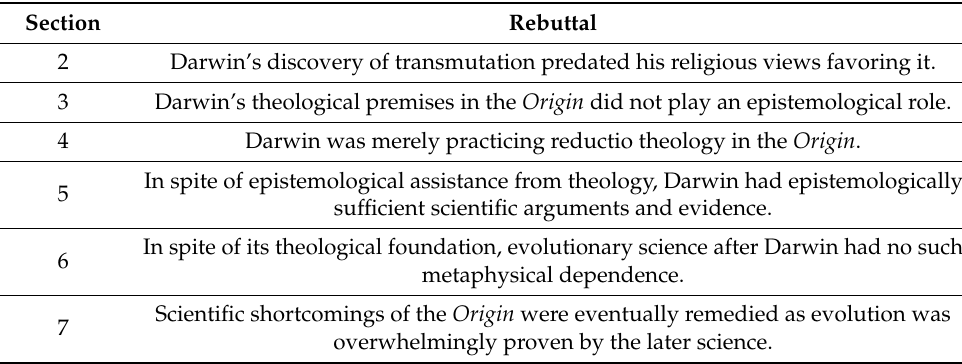
Table 1. The failure of six different